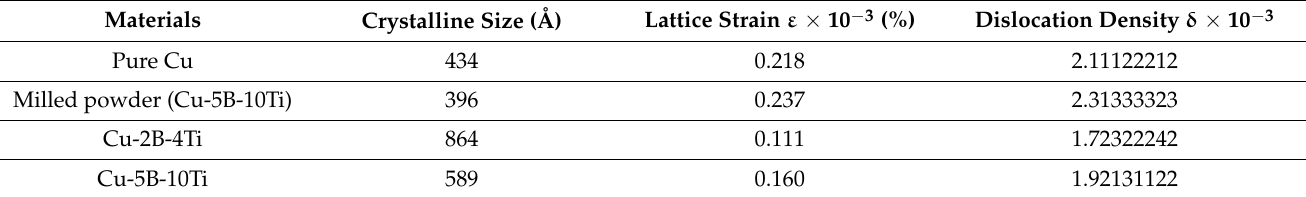
Table 1. Calculation of dislocation density, lattice strain, and crystallite size of pure Cu and milled powder and the two types of alloy composite utilizing